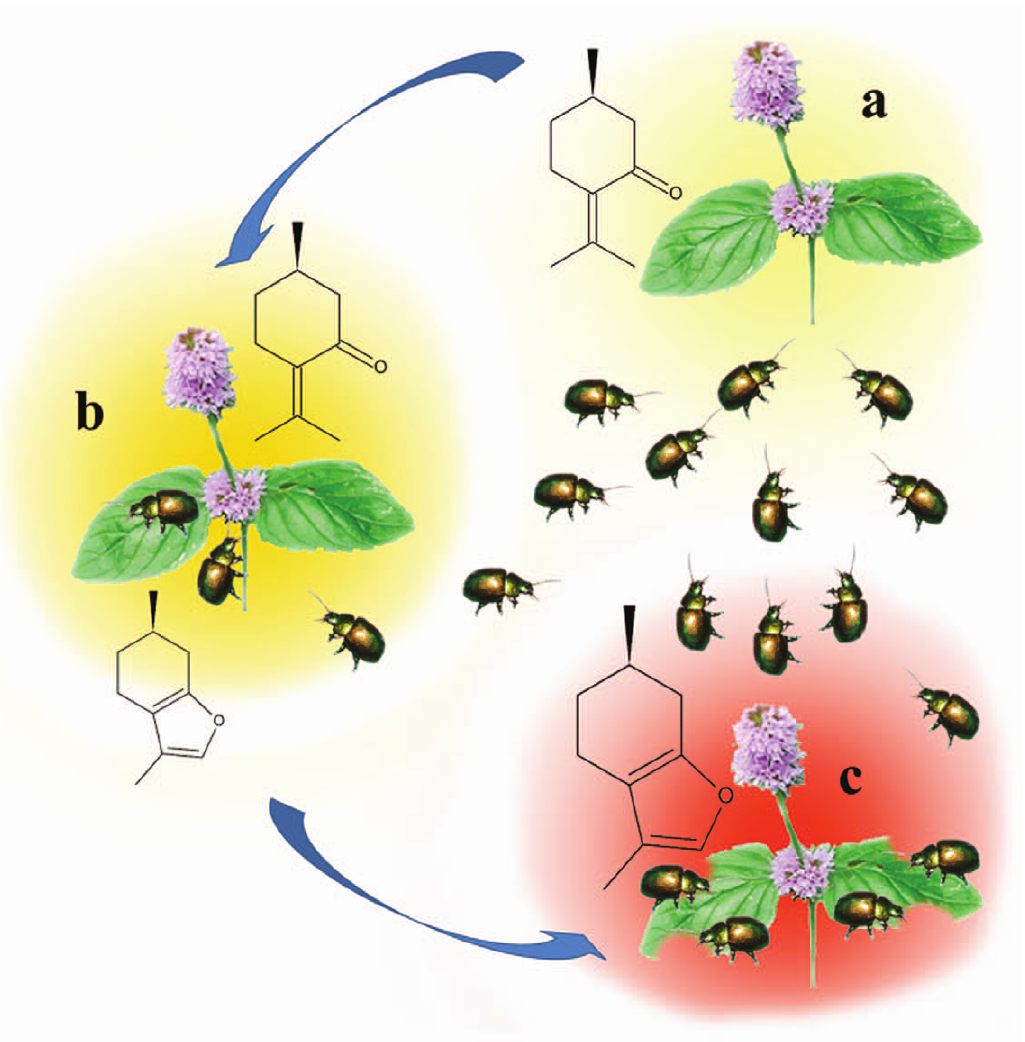
Figure 6. The behavior of C.herbacea and M.aquatica before and during herbivore feeding. a , Undamaged plants emit ( + )-pulegone, which acts as an attractant for C. herbacea . b , Feeding activity induces gene expression and increases content of the deterrent compound ( + )- menthofuran, along with the emission of the attractant compound ( + )-pulegone; as a result, fewer insects are attracted to the plants. c , Intense feeding induces a reduction in ( + )-pulegone content and a dramatic increase in the repellent compound ( + )-menthofuran; C. herbacea avoids over- fed plants and moves towards undamaged plants.